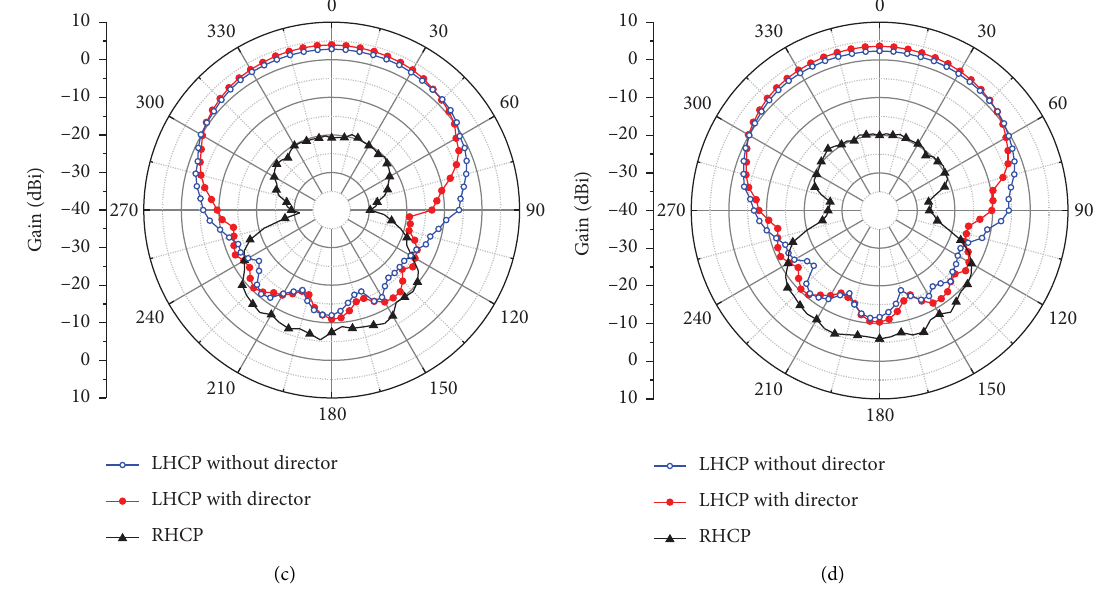
Figure 9: Radiation pattern of the proposed antenna at (a) 1.98GHz, (b) 2.01GHz, (c) 2.17GHz, and (d) 2.2GHz. Table 2: Gain at the zenith angle of 0 ° and 35 ° for diferent frequencies. Frequency (GHz) Gain at the zenith angle of 0 ° (dBi) Gain at the zenith angle of 35 ° (dBi)